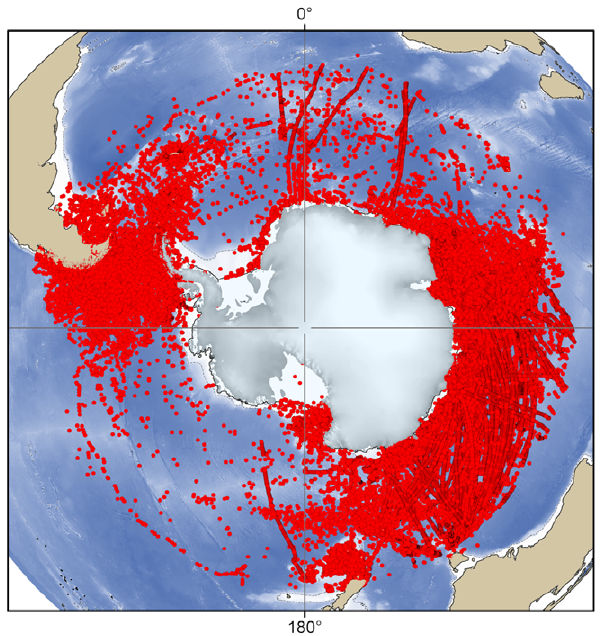
Figure 4. The distribution of the more than 1 million SCAR- MarBIN sample locations in the Southern